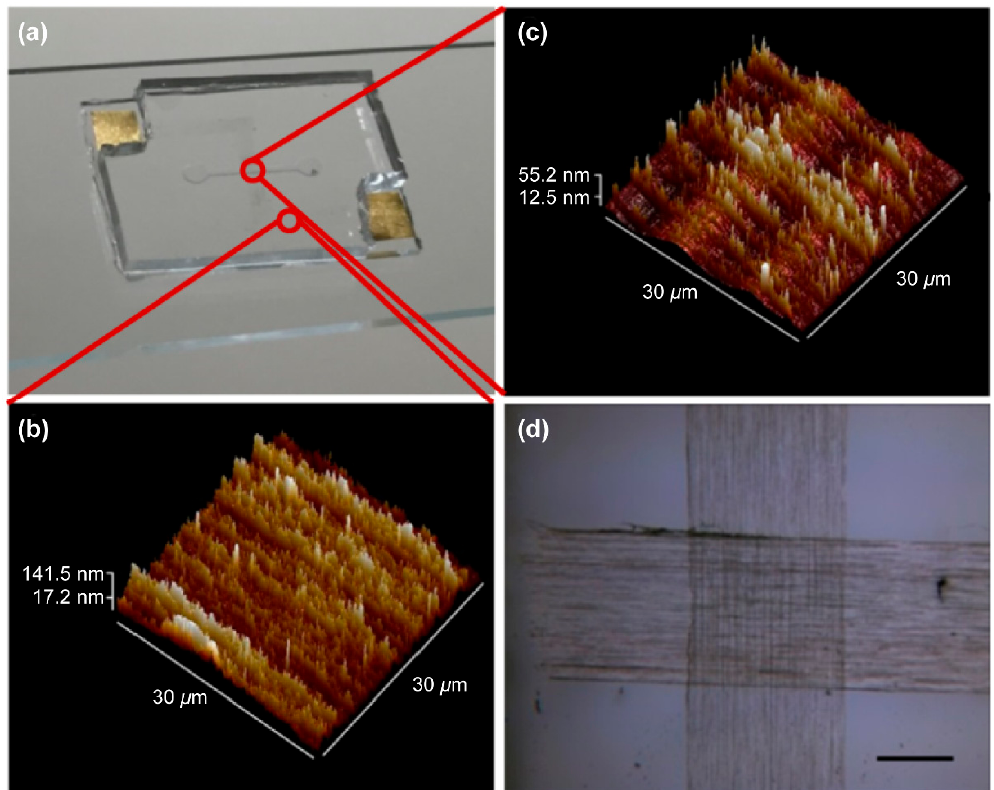
Figure 1. Image of the manufactured all-CNT-based device. ( a ) Actual appearance of the CNT-based device. ( b ) AFM image of the electrode composed of CNT layers. The electrodes consist of a CNT layer with an average thickness of 90 nm. ( c ) AFM image of the CNT layers used as active channels of the device. The channel has an average thickness of 40 nm and CNTs in the channel have a density of 0.03 CNTs/ μ m 2 . ( d ) Microscopic image showing contact between electrodes and channels made up of CNT layers; scale bar = 500 μ m.